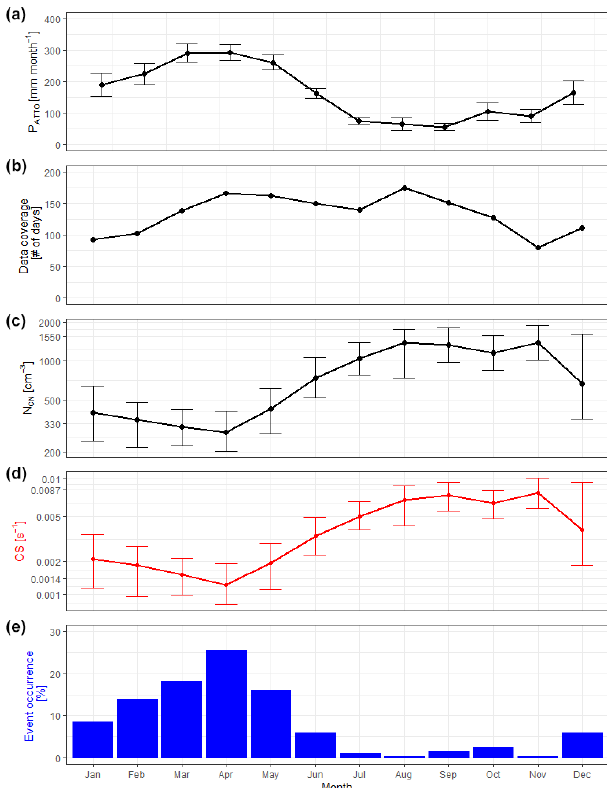
Figure 6. The seasonal cycles of selected meteorological and aerosol parameters presented as monthly averages for the entire observation period from February 2014 to June 2020. From top to bottom: (a) P ATTO monthly rain measured at ATTO, where er- ror bars denote the standard deviation. (b) SMPS data coverage as the number of measurement days. (c) Median total particle number concentration in the size range of 10nm <D < 400nm, calculated from SMPS data, where error bars denote the interquartile range (please note the logarithmic scale). (d) Median condensation sink per month calculated from SMPS data, where error bars refer to the interquartile range (please note the logarithmic scale). (e) Annual cycle of the occurrence of CN < 50 particle growth events.